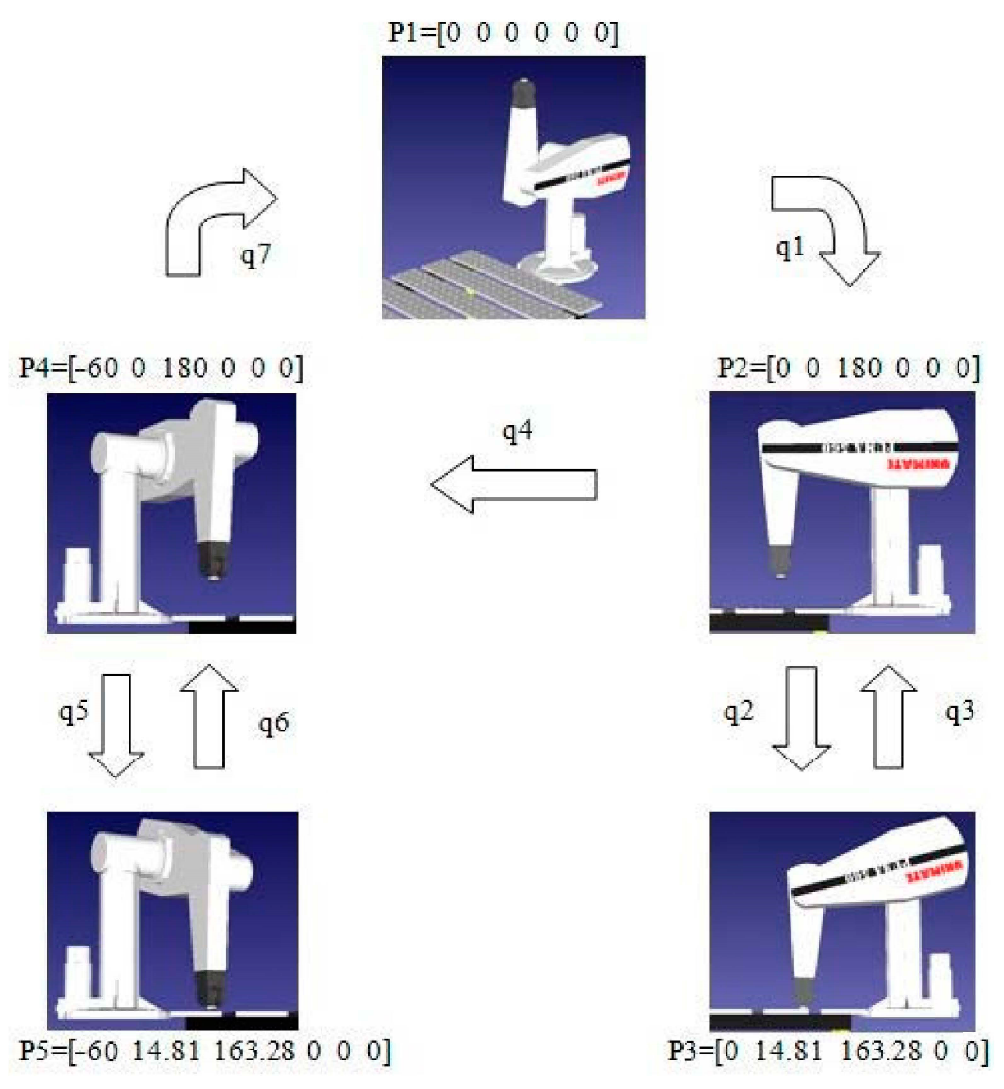
Figure 3. Example of programming the robot and reading the values of angles [23].